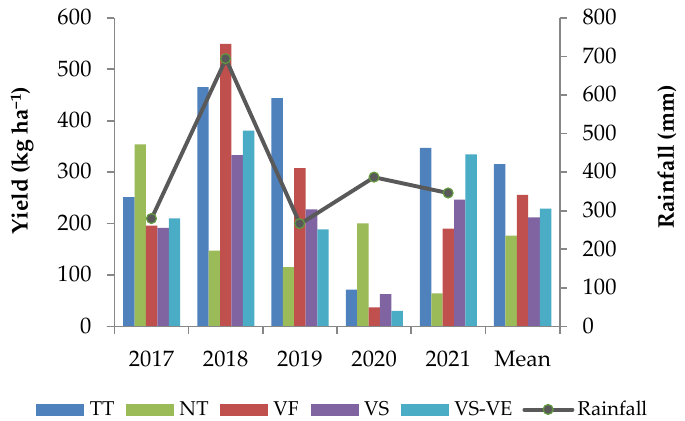
Figure 7. Annual almond yield response to different soil management strategies and rainfall depths for each growing season. TT, traditional tillage; NT, no tillage; VF, cover of V. faba ; VS, cover of V. sativa ; VS-VE, cover of V. sativa and V. ervilia .